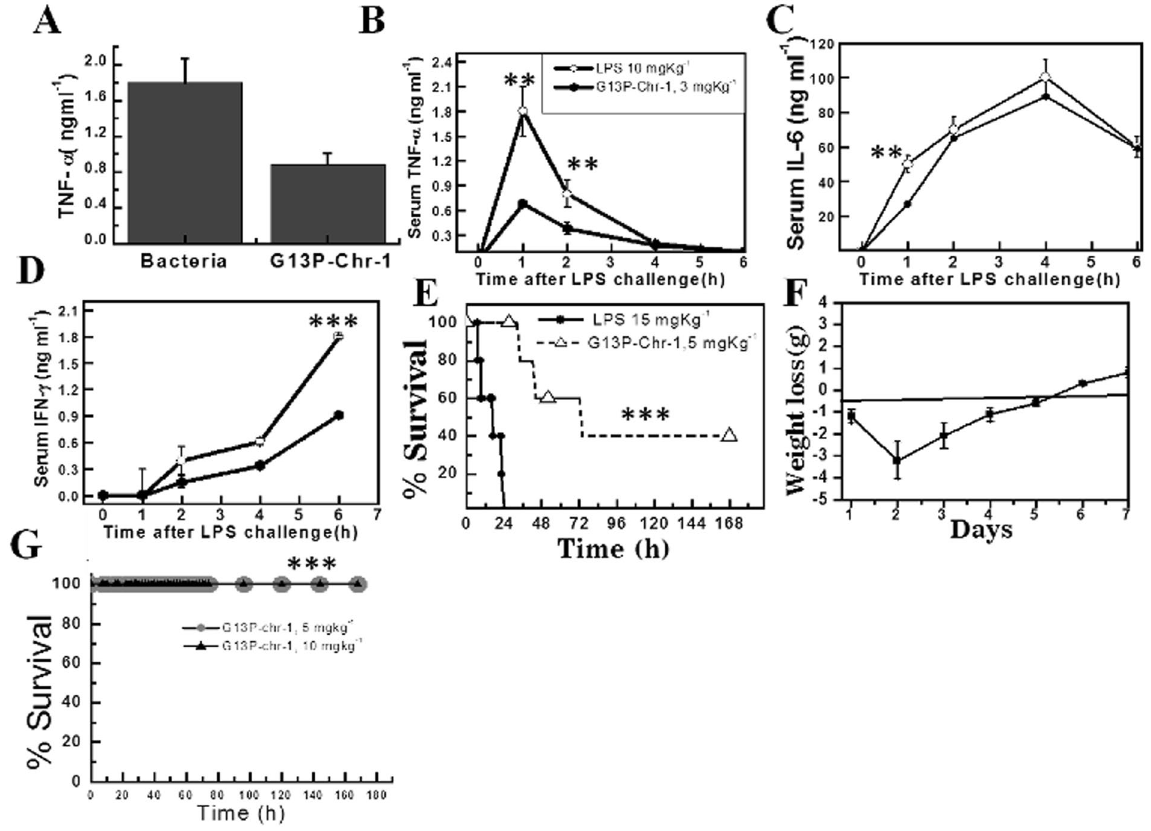
Figure 8. In vivo anti-endotoxin activities of G13P-Chr-1. ( A ) Inhibition of TNF- α production two hours post infection to mice with mid-logarithmic phase E. coli ATCC 25922. ( B ) Serum levels of at different time points when mice were injected with indicated concentrations of LPS and peptides. ( C ) and Panel D , Serum levels of IL-6 and IFN- γ at various time points. ( E ) Anti-LPS survival assay of G13P-Chr-1 to show its protective effects. LPS was injected intraperitoneally followed by peptides treatment. ( F ) Plot of weight loss (g) of G13P- Chr-1 peptide-treated mice, challenged with LPS with respect to the number of experimental days. No animals survived in the peptide-untreated group that were challenged with LPS (after day 2); hence the weight curve for peptide-untreated mice is not shown. ( G ) In vivo toxicity of G13P-Chr-1. BALB/c mice were injected intraperitoneally with the peptide (5 and 10 mgkg − 1 of body weight). All these mice were alive after 7 days. Symbols, as indicated in B. The quantity of cytokines, were obtained by the standard curve for each cytokine ( A – D ). Error bars represent the possible amount of error in each dataset ( A – D ). P value was determined by the log-rank test. ( *** P < 0.001, ** P <